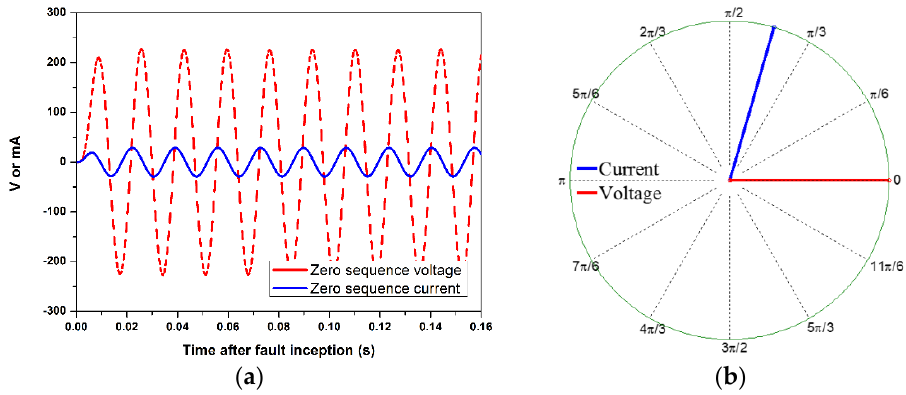
Figure 16. The zero-sequence voltage and current at the secondary winding of the step-down transformer in the case of a microgrid fault in grid-connected mode: ( a ) Zero-sequence voltage and current; ( b ) Phase relation.